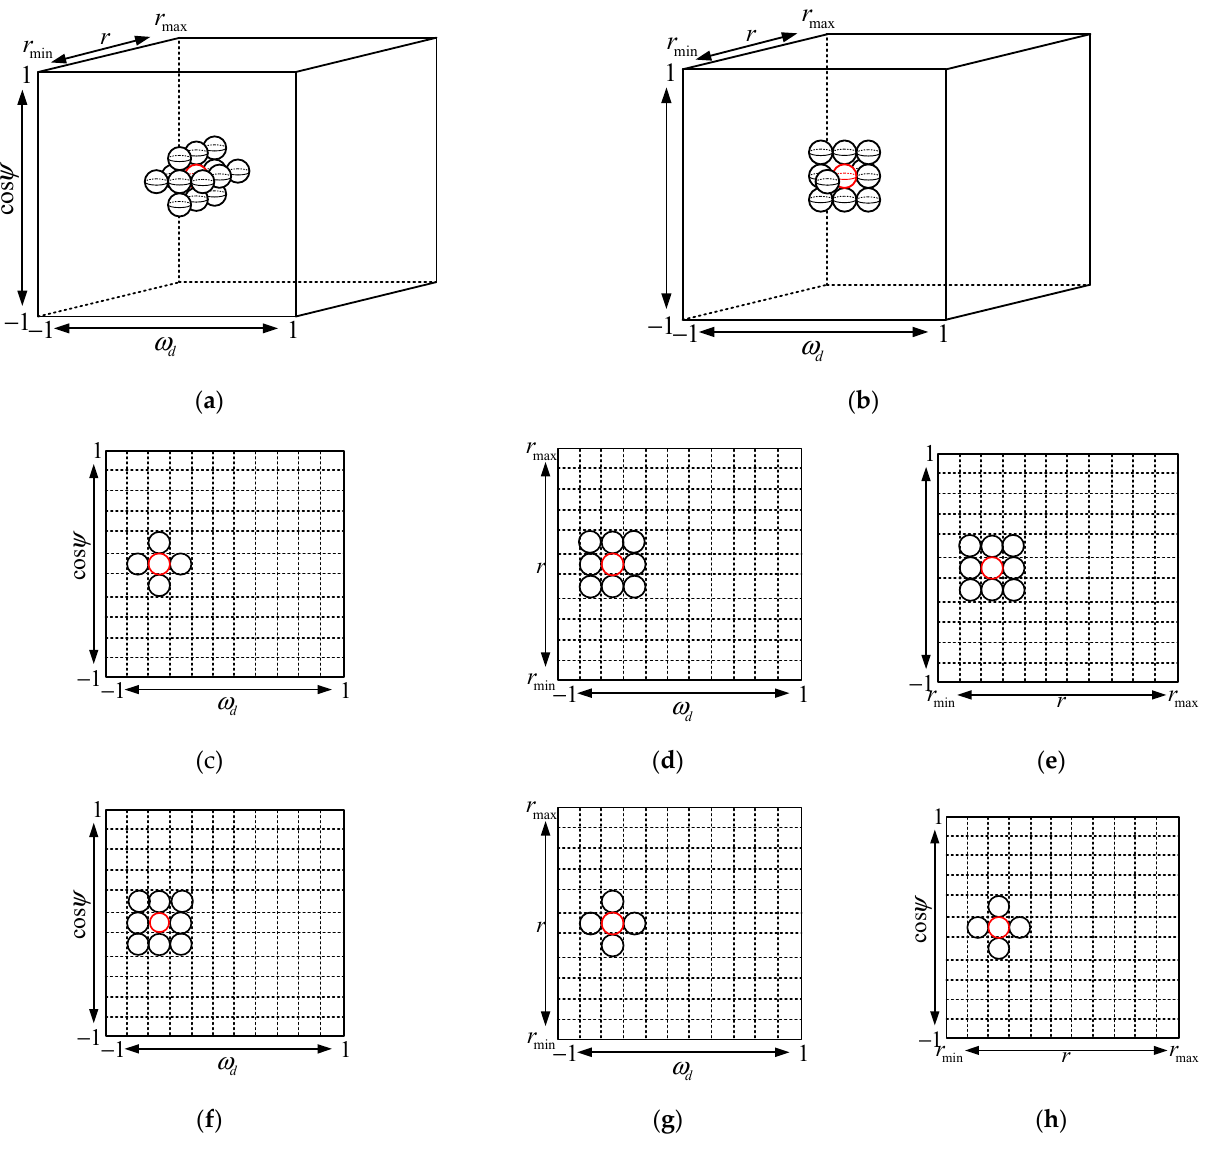
Figure 5. Auxiliary channel selection structure for different dimensionality reduction method: ( a ) Method 3.c; ( b ) Method 3.d; ( c – e ) Downscaling structure in different domain of method 3.c; ( f – h ) Downscaling structure in different domain of method 3.d.